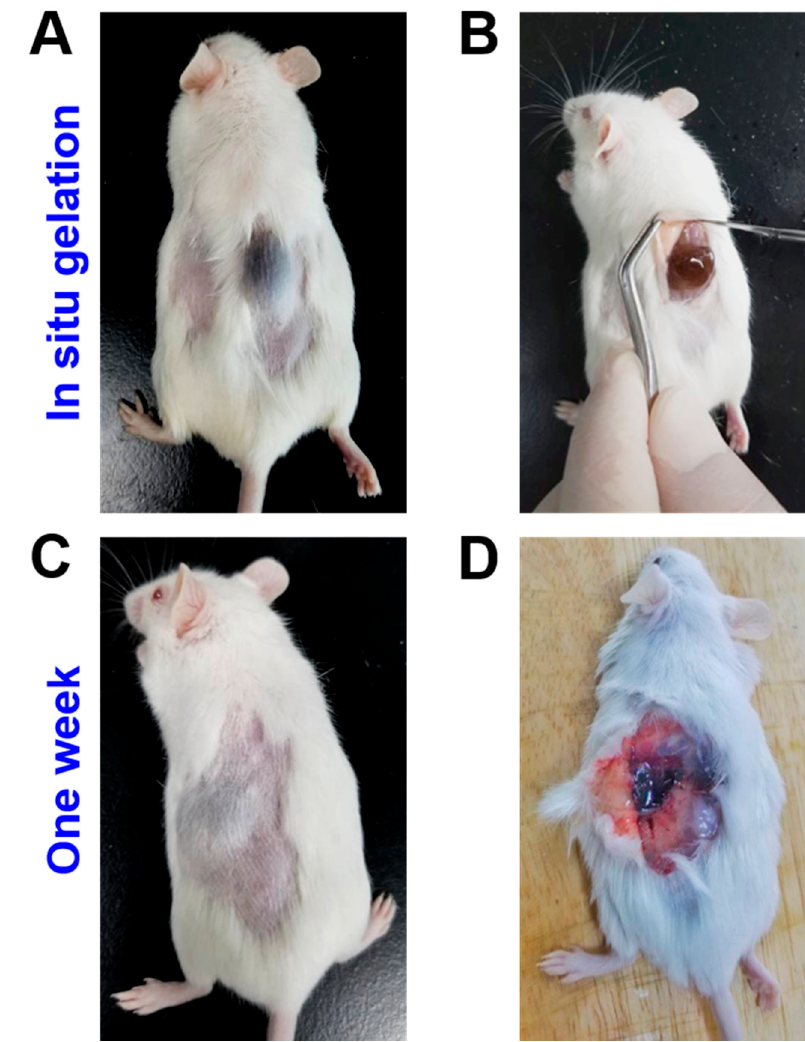
Figure 7. Photographs of the in vivo study: ( A ) Grey bumps of GO-SA hydrogel cured under the mice’s skin after hypodermic injection, ( B ) Incision to test stable gel formation of the hydrogel. ( C ) After a week, the hydrogel remained stable without inflammation and ( D ) After 1 week, disintegration of the GO-SA hydrogels was observed. This is mainly due to the slow exchange of cations and salt effects.